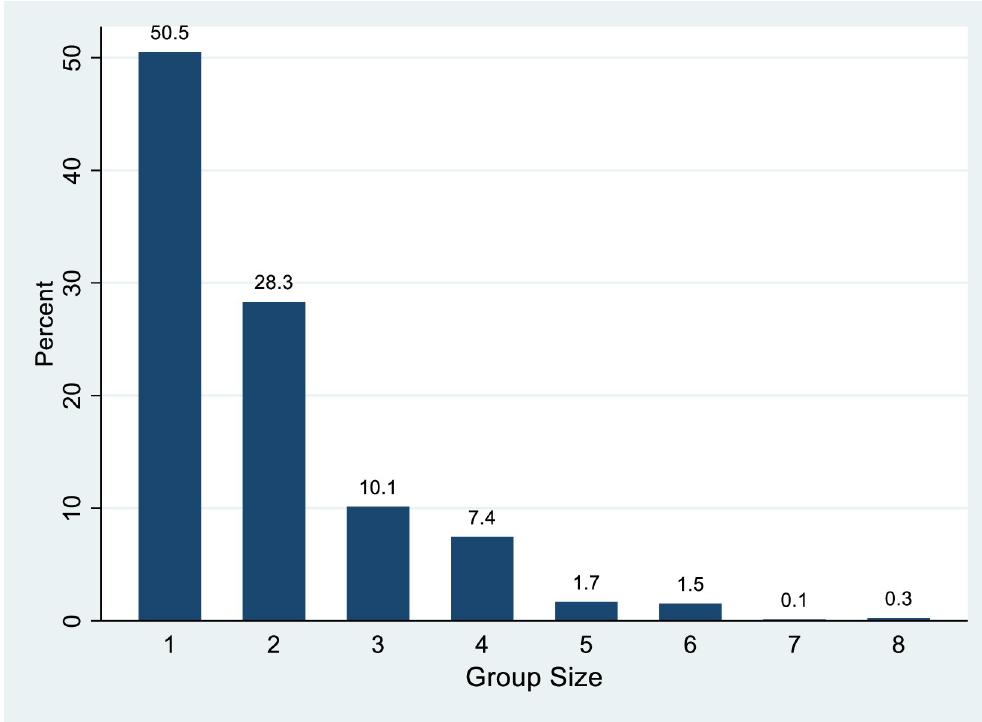
Fig 5. Percentage distribution of group